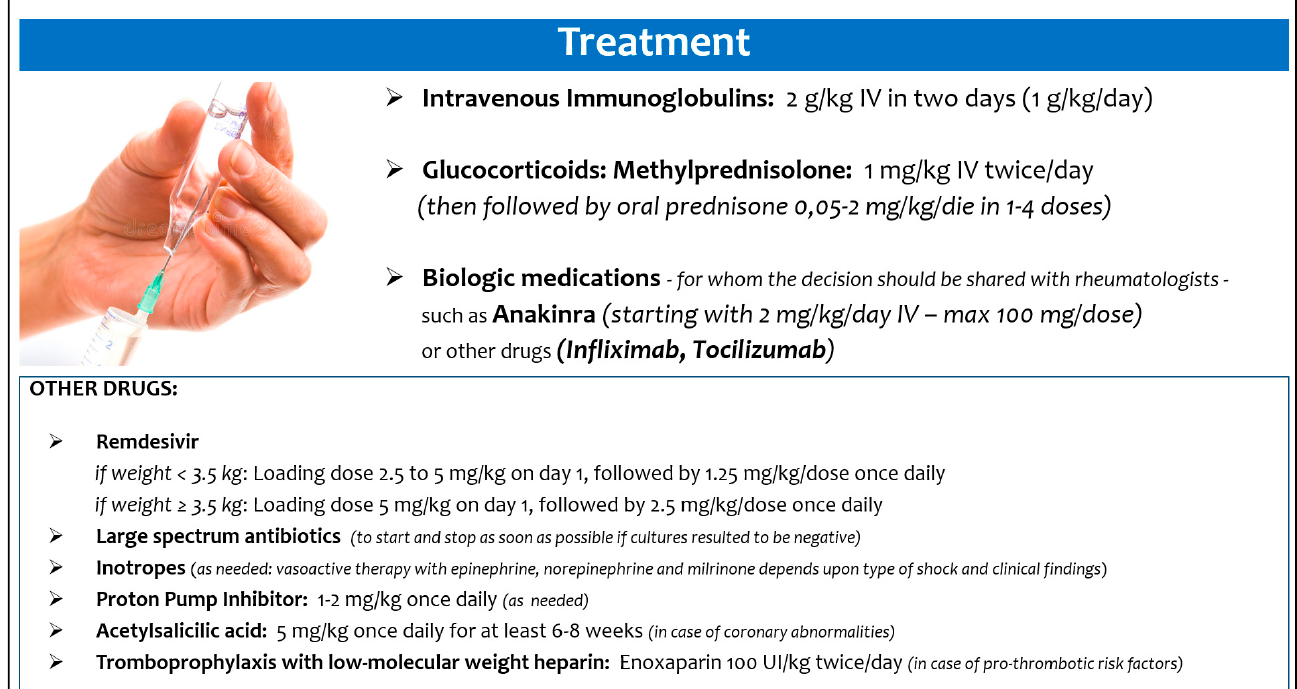
Figure 5. Suggested treatment of multisystem inflammatory syndrome in neonates and infants. MIS-C and MIS-N seem to originate from immune-mediated mechanisms, in the set- ting of a suspected or confirmed SARS-CoV-2 infection: however, in MIS-N the primary source is the maternal infection in pregnancy, with transplacental passage of maternal antibodies [62], whereas in MIS-C the infant contracts a postnatal infection and mounts an antibody response with intact neutralization capability [72]. The efficacy of intravenous immunoglobulins (IVIG) in MIS-C, a common approach to activating inhibitory Fc-receptors and preventing membrane-attack complexes by complement factors, thereby mitigating autoantibody-mediated pathology [73], lends support to the hypothesis that autoantibodies contribute to MIS-C pathogenesis [74].